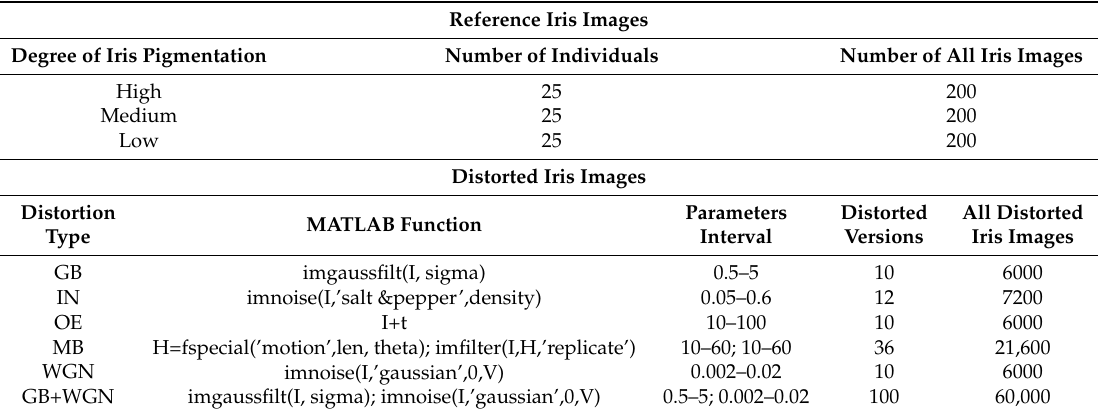
Table 1. Summary of the artificially distorted iris image